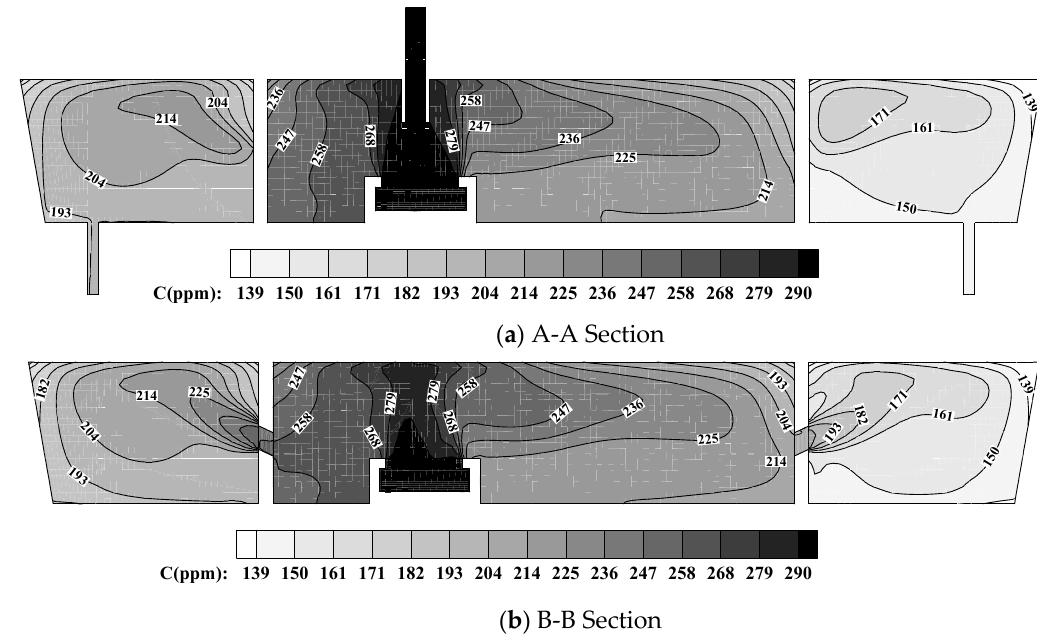
Figure 11. Inclusion volume concentration distribution in the optimized tundish.